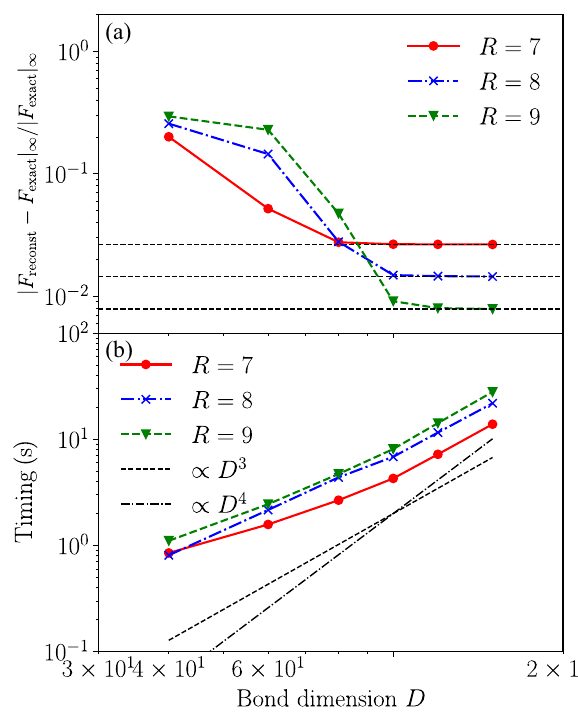
FIG. 25. (a) Error in the reconstructed full vertex by solving the BSE, (b) timings of the one-shot solution of the BSE for U ¼ 3 and R ¼ 7 , 8, 9. The BSE is solved effectively on a 2 R × 2 R × 2 R grid. The horizontal dashed line in (a) denotes the error level set by the finite-size effects of the grid (see the text). The symbol j (cid:2) (cid:2) (cid:2) j ∞ denotes the maximum norm of a